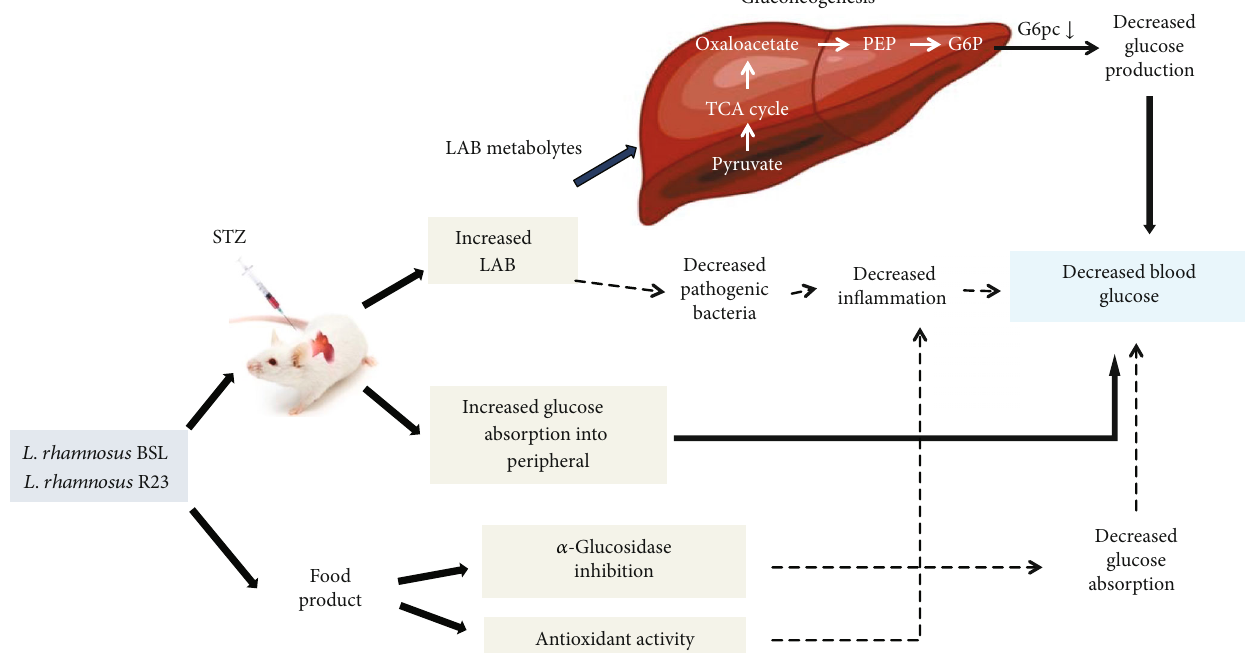
Figure 7: Possible mechanism involved antidiabetic e ff ect of L. rhamnosus BSL and L. rhamnosus R23 on a diabetic rat model induced by STZ. The alleviation of fasting blood glucose and downregulation of G6pc in diabetic rats was assumed to originate from LAB metabolytes absorbed into the blood and circulated throughout the